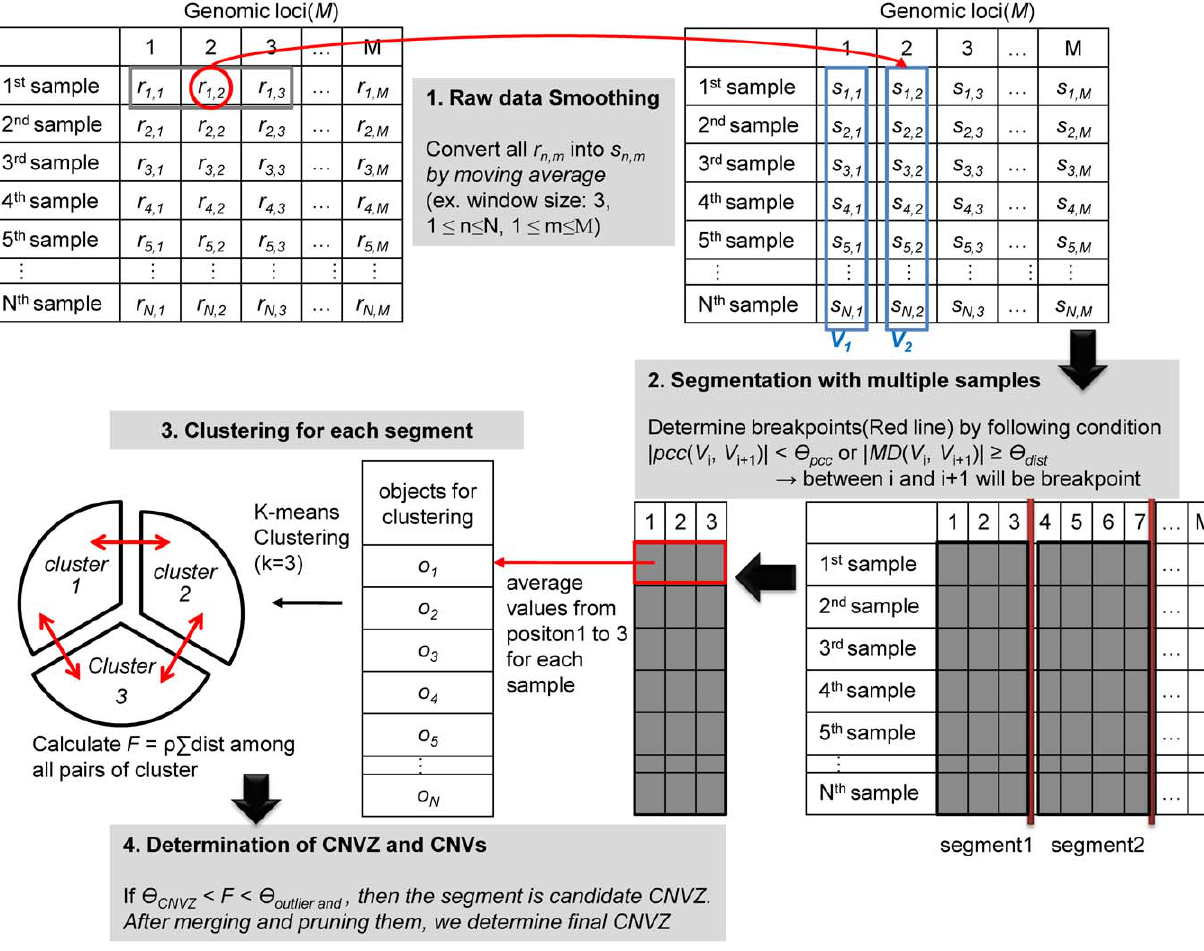
Figure 8. Schematic Process Flow Chart of MGVD for high resolution aCGH data. MGVD consists of four phases which are sequentially executed. We find candidates in advance through phases 1 and 2. Then we get the final results through phases 3 and